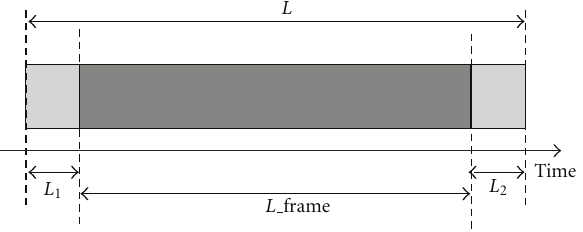
Figure 7: The TCX input audio frame structure. After the perceptual weighting filter, the signal goes through the adaptive windowing module. The adaptive window is shown in Figure 8.